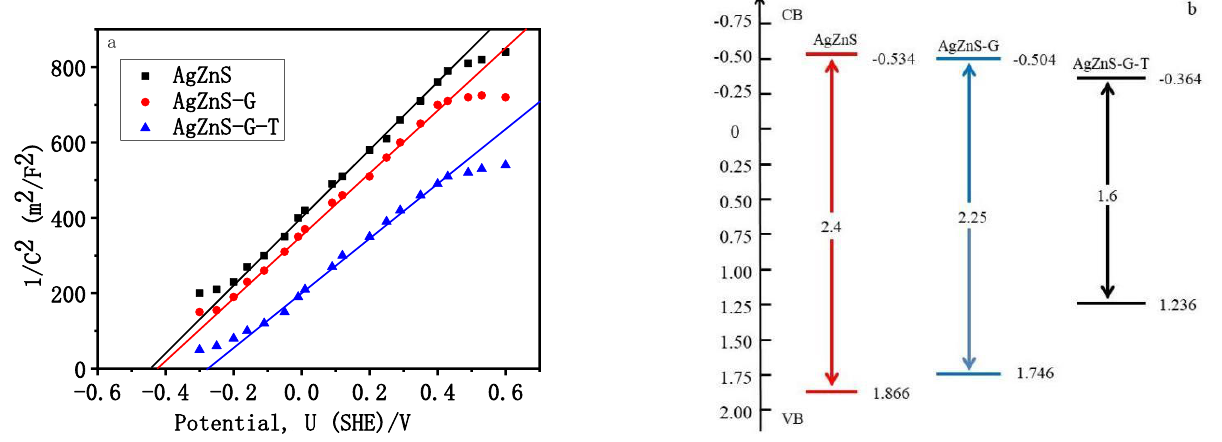
Figure 6. ( a ) Mott – Schottky analysis for calculation of donor density and flat band potential with 500 Hz frequency; ( b ) the band alignment of the prepared photocatalysts.